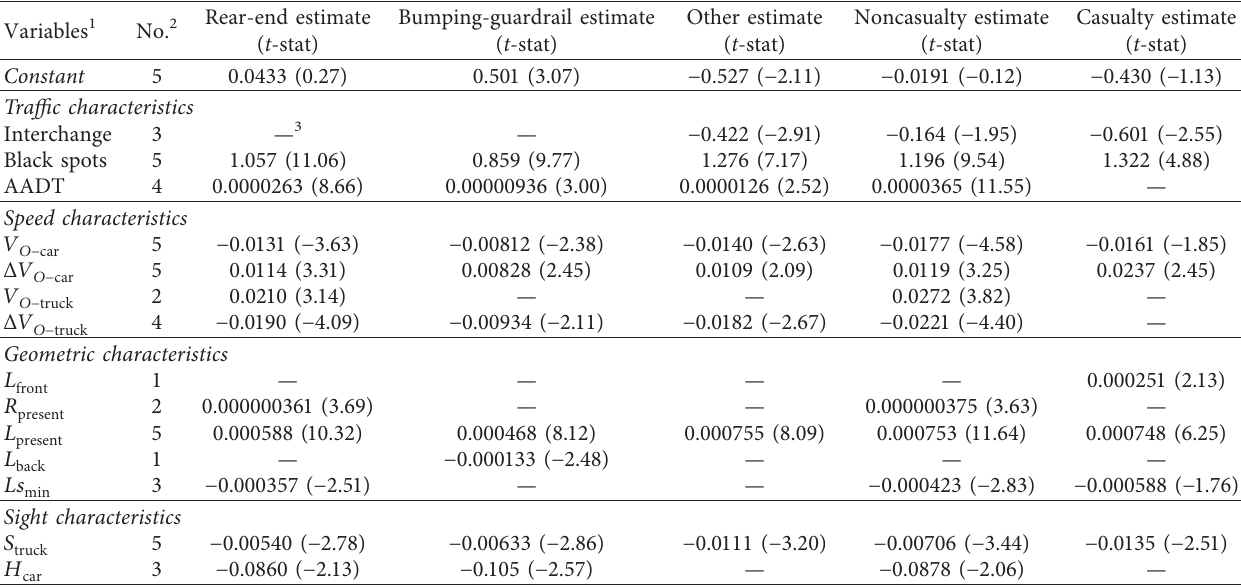
Table 9: Zero-inflated multivariate negative binomial model estimation results.